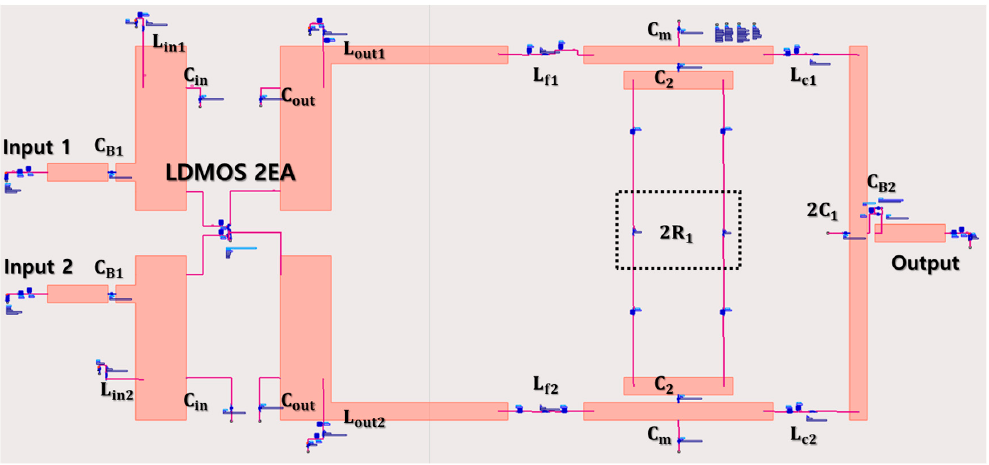
Figure 8. Electromagnetic (EM) field and radio frequency (RF) circuit co-simulation of the proposed power module including the effects of the layout design on FR4 PCB. Table 2. Design parameters of the proposed power module in Figures 7 and 8.